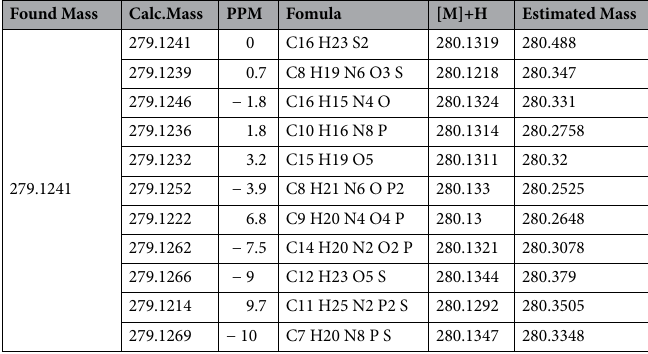
Table 1. The list of estimated anti-tumor molecules derived from A.